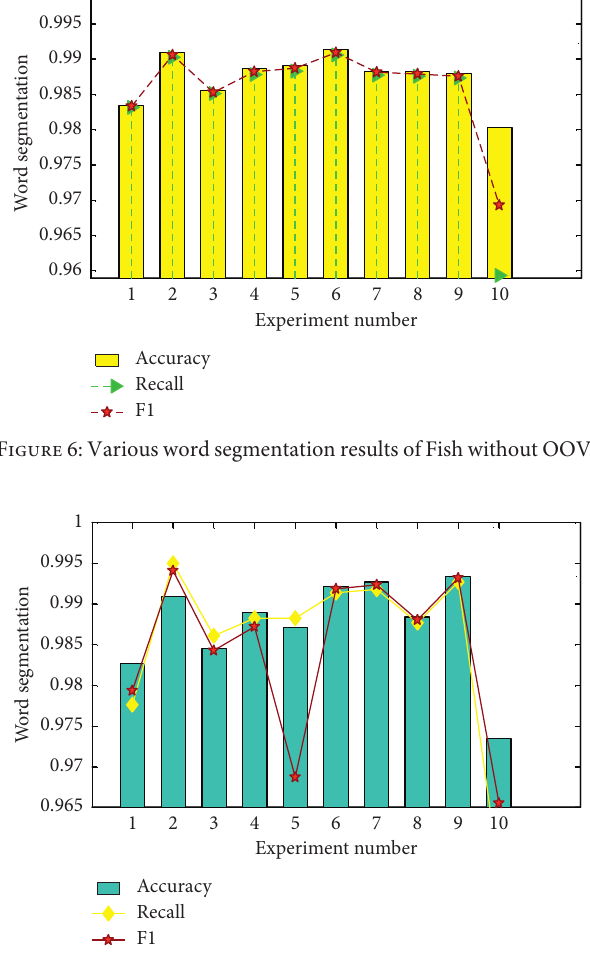
Figure 7: Bird’s various word segmentation results without